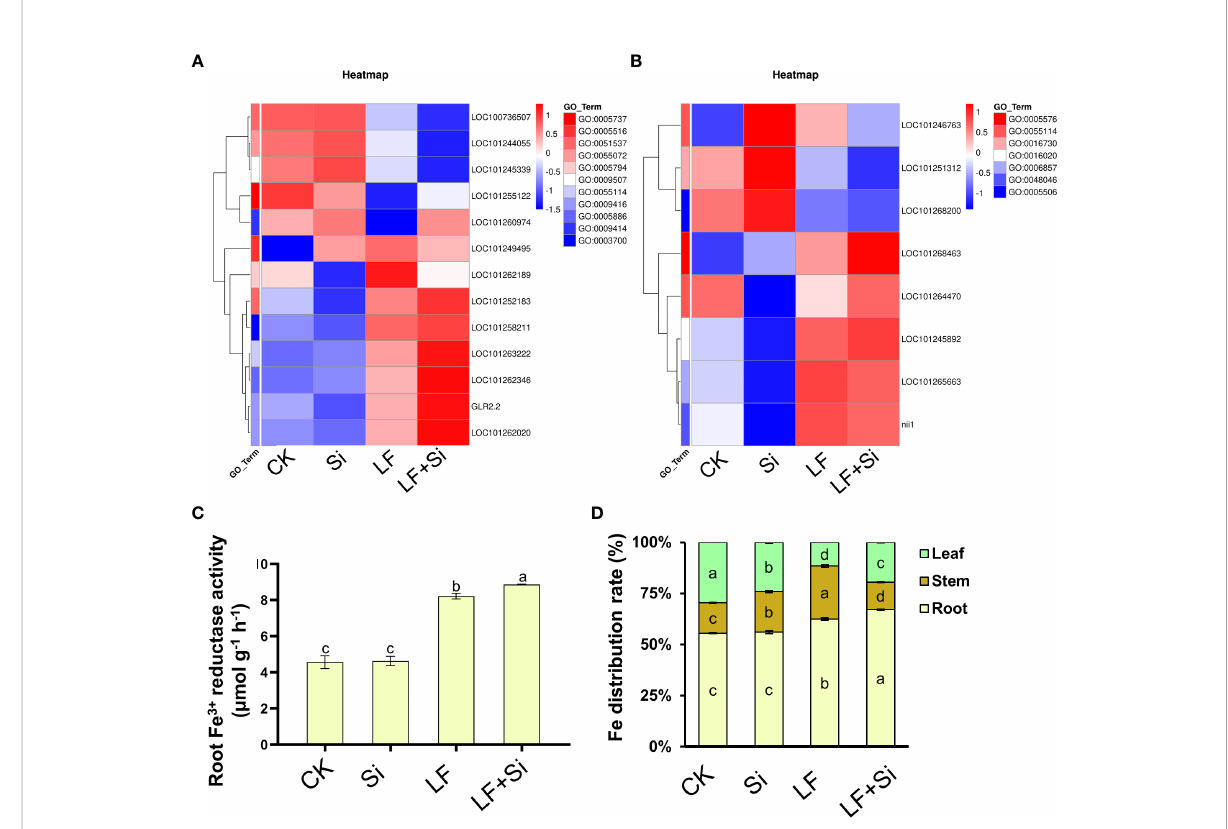
FIGURE 8 Effects of silicon application on absorption capacity of Fe under Fe de fi ciency in tomato. (A) Heat map of related leaf differentially expressed genes. (B) Heat map of related root differential genes. (C) Root Fe 3+ reductase activity. (D) Fe distribution rate (%) in tomato plants. Each data point represents the mean of three independent biological replicates (mean ± SD). Different letters above the bars indicate statistically signi fi cant differences ( P